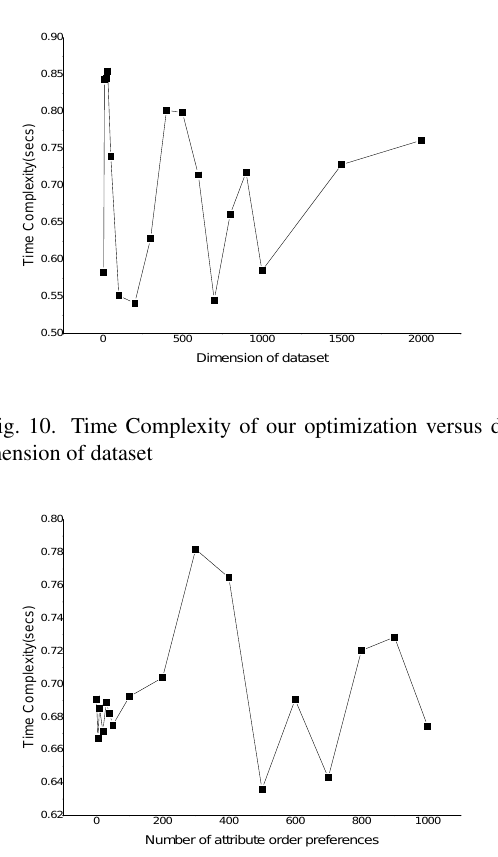
Fig. 11. Time Complexity of our optimization versus num- ber of attribute order